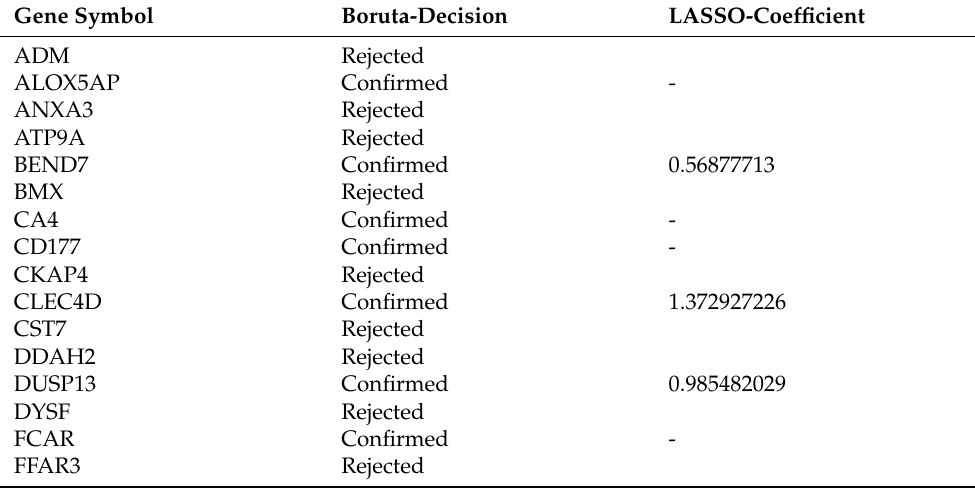
Table 1. The detailed results of the Boruta and LASSO